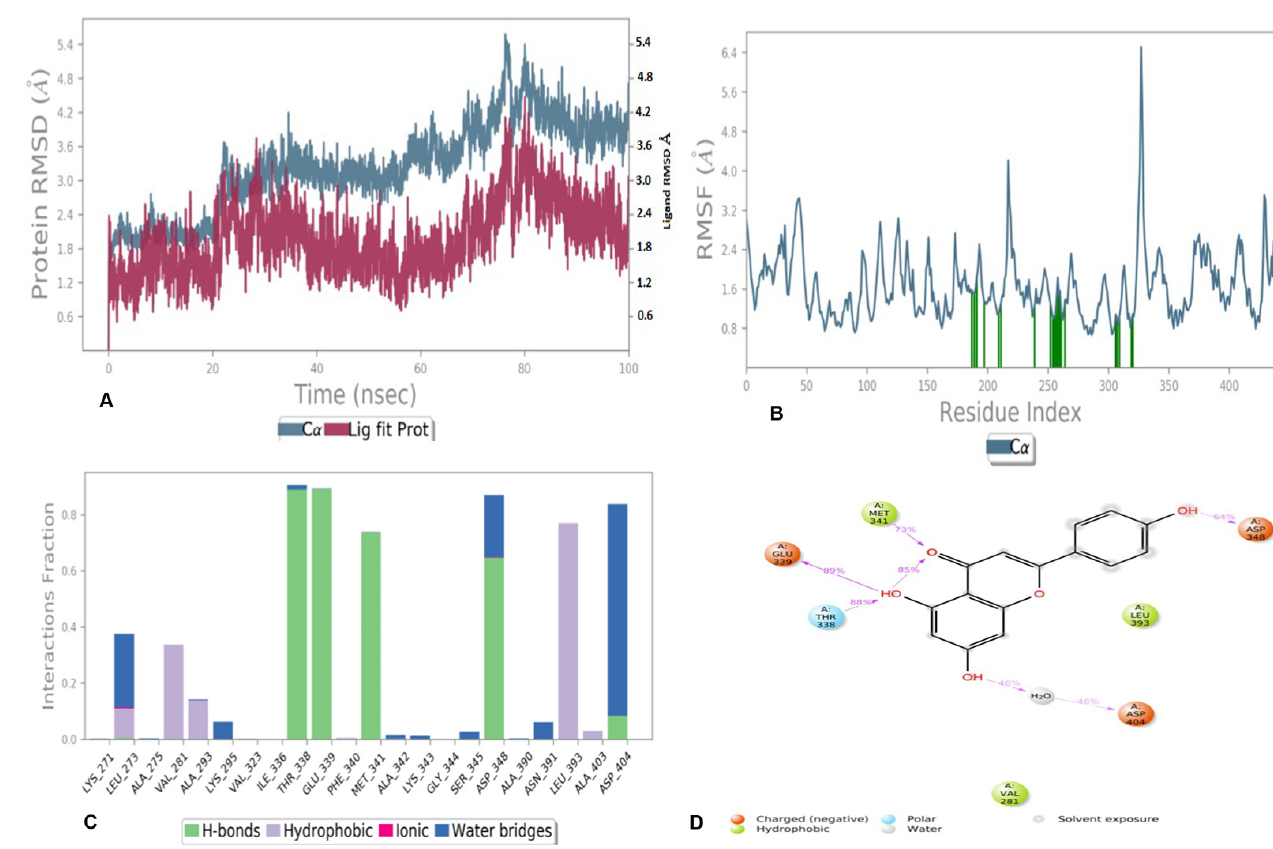
Figure 9. MD simulation results of compound 5 with receptor 2HCK: ( A ) Time-dependent protein- ligand root mean square deviation (RMSD) plots, ( B ) Root mean square fluctuation (RMSF) plots, ( C ) Simulation interactions diagram with bar diagram indicating the fold of interaction, fraction, and contacts, and ( D ) 2D binding interactions.